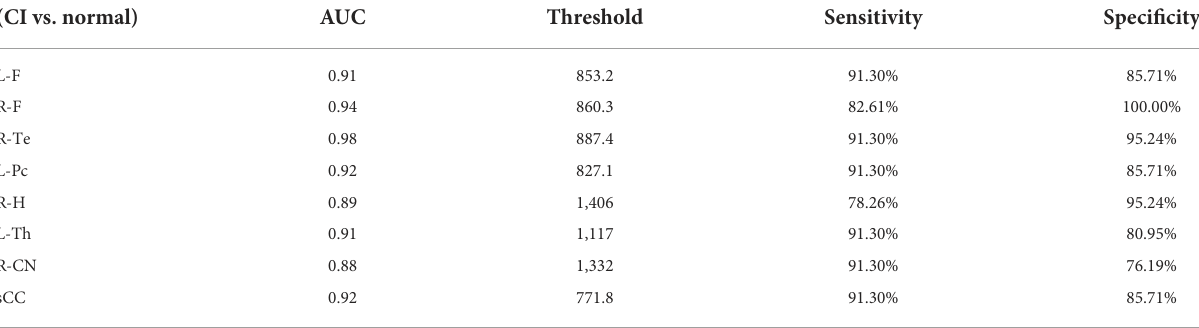
TABLE 7 Coordinate points of receiver operating characteristic (ROC)